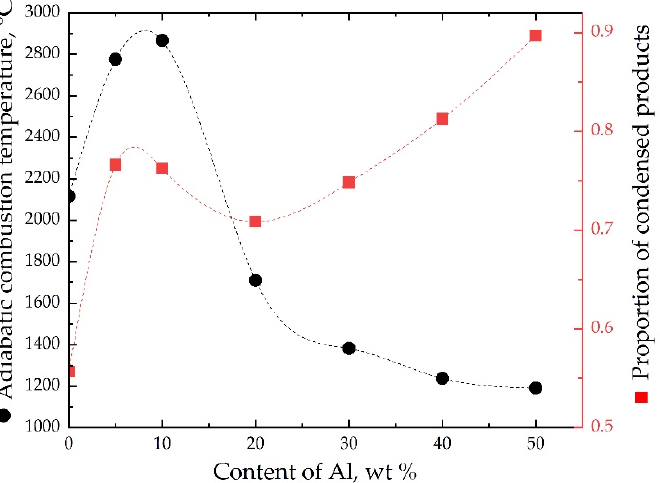
Figure 6. Adiabatic combustion temperature and the proportion of condensed products in the W/PTFE/Al system as a function of the aluminum content.